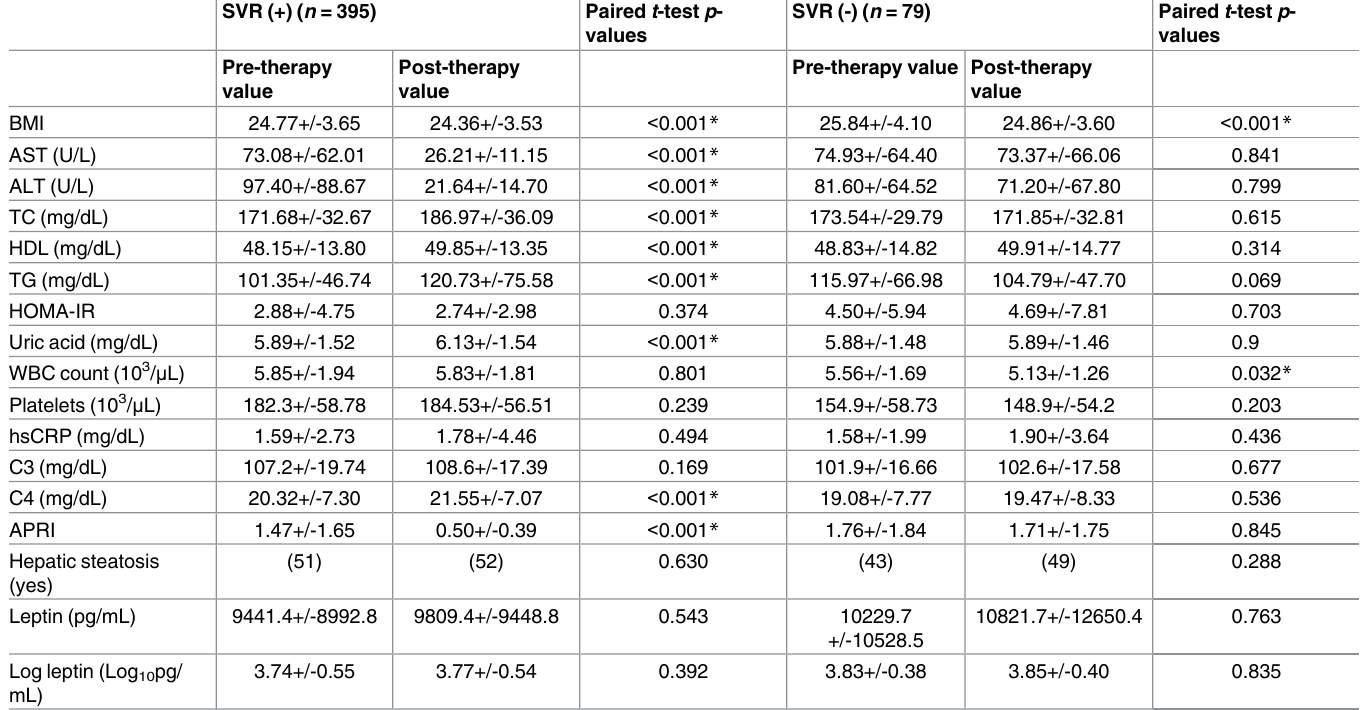
Table 4. Comparison of the pre- and 24-weekpost-therapy variables in CHC patients stratified by the therapeutic response. SVR (+) ( n = 395) Paired t -test p - values